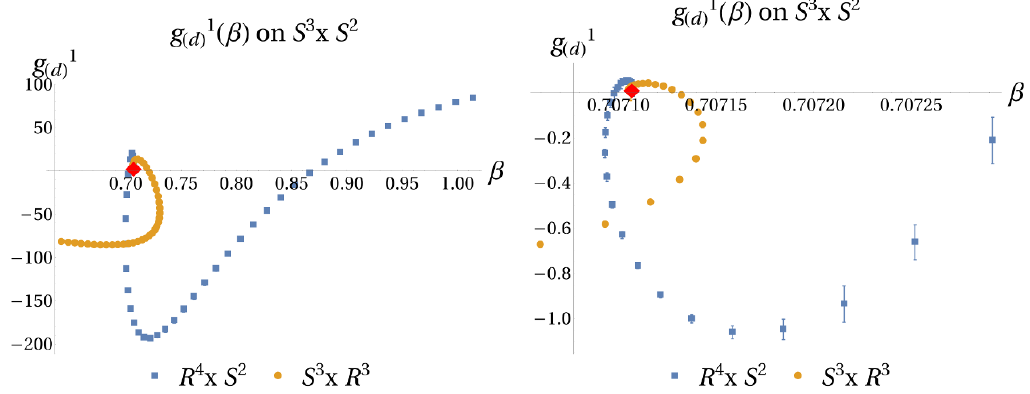
Figure 4 . g 1 as a function of the ratio of radii (cid:12) for both topologies with conformal boundary ( d ) S 3 (cid:2) S 2 . This is proportional to the expectation value of the energy-momentum tensor. The red diamond is the analytical calculation for the singular ratio (cid:12) s .